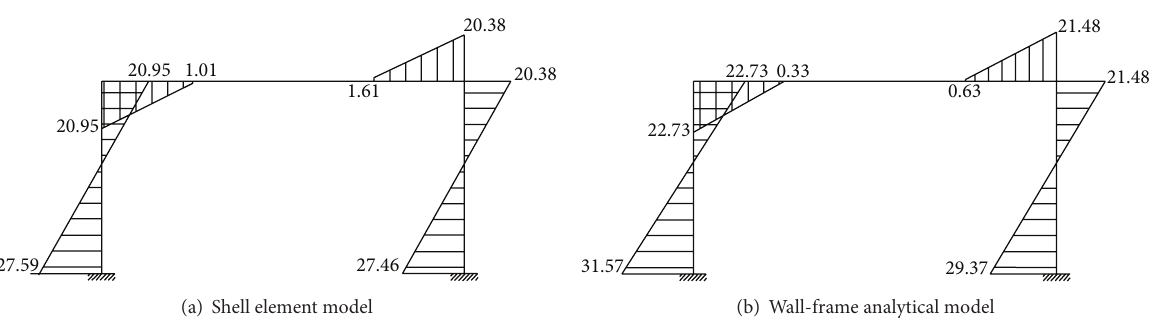
Figure 17: Moment diagrams of the steel frame under the drift angle of 1/100(kN ⋅ m).